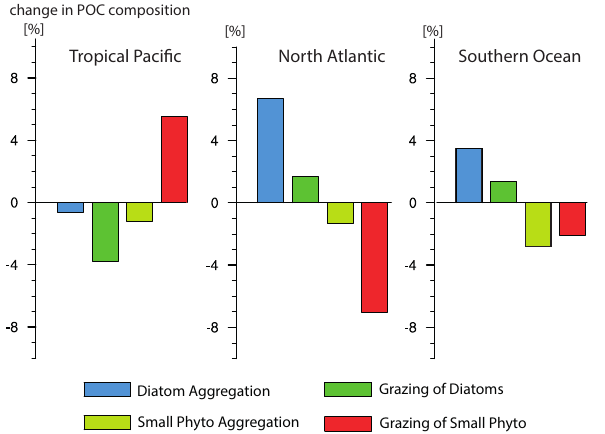
Fig. 9. Changes in POC composition in % in the Southern Ocean, tropical Pacific and North Atlantic between beginning (1960–1970) and end (1996–2006) of simulation period. We obtain the changes by calculating the percentage of each mechanism’s contribution to total POC and then computing the difference between the percent- aged fraction of POC at the beginning and the end of the study pe- riod. The changes are significant within the 95% confidence inter- val.